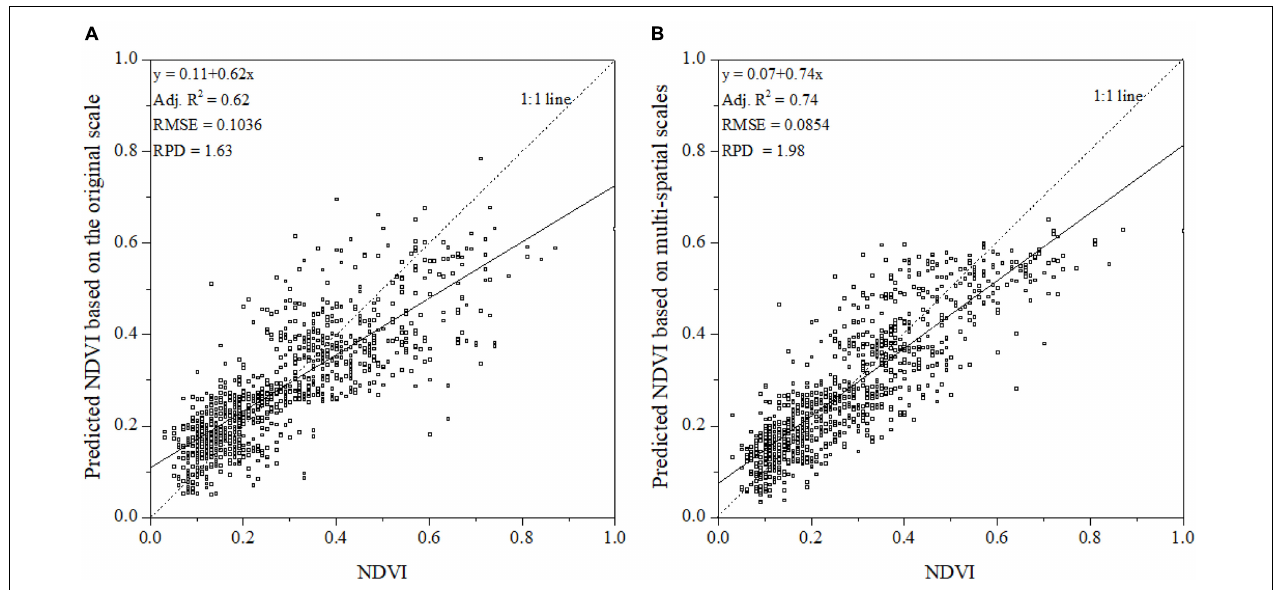
FIGURE 9 | Scatter plots between NDVI and predicted NDVI using SMLR based on climatic factors (A) at the original scale, and (B) at multi-spatial scales. NDVI, normalized difference vegetation index; SMLR, stepwise multiple linear regression.